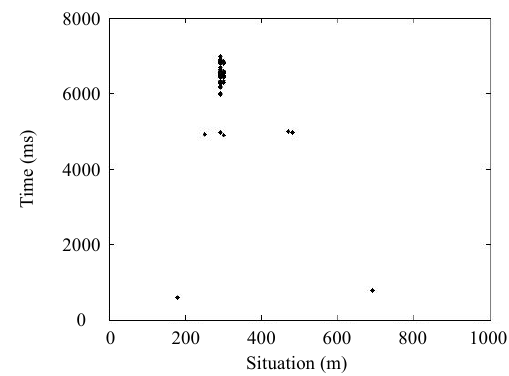
Fig. 9 Detection result of CFAR.